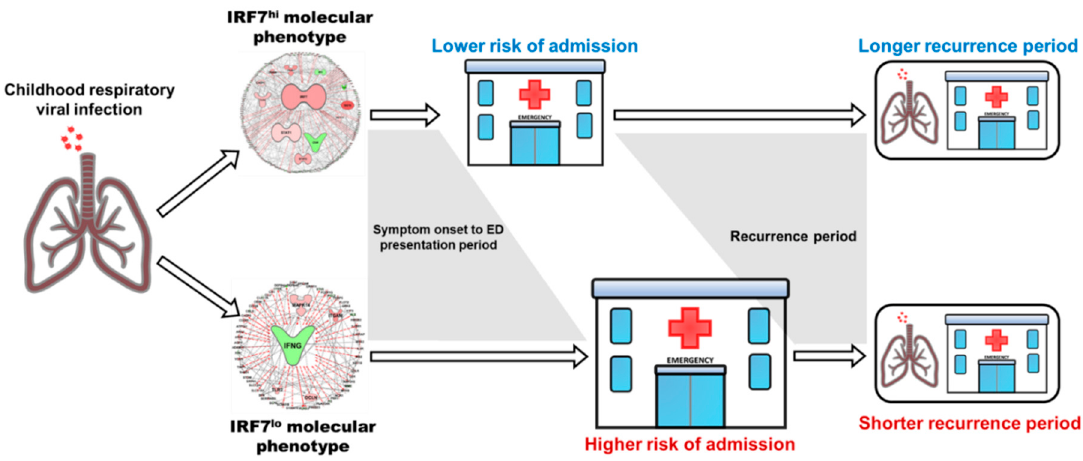
Figure2. SchematicrepresentationofoutcomesassociatedwithIRF7hiandIRF7lomolecularphenotypes Figure 2. Schematic representation of outcomes associated with IRF7hi and IRF7lo molecular underlying severe exacerbations of asthma and wheeze. Gene network diagrams reproduced with phenotypes underlying severe exacerbations of asthma and wheeze. Gene network diagrams permission; originally published in The Journal of Immunology [83], copyright © 2020 The American reproduced with permission; originally published in The Journal of Immunology [83] , copyright © 2020 Association of Immunologists, The American Association of Immunologists, Inc.